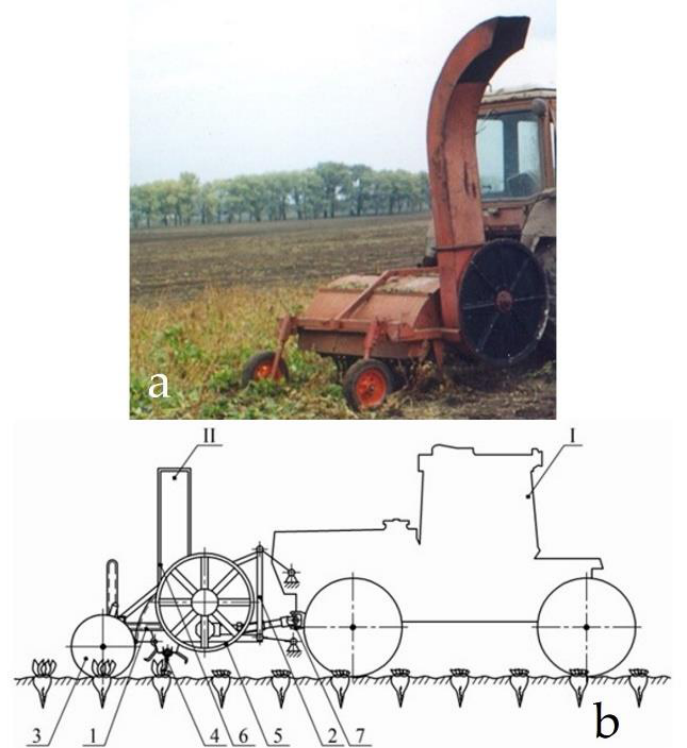
Figure 1. Front-mounted beet leaves harvester equipped with a rotary cutting unit linked to an aggregate tractor: ( a ), general view; ( b ), structural and technological scheme. I, wheeled rowing tractor; II, front-mounted beet leaves harvester: 1, frame; 2, connecting device; 3, feeler wheel; 4, rotary leaves cutting device; 5, transport device; 6, discharge chute; 7, drive shaft.